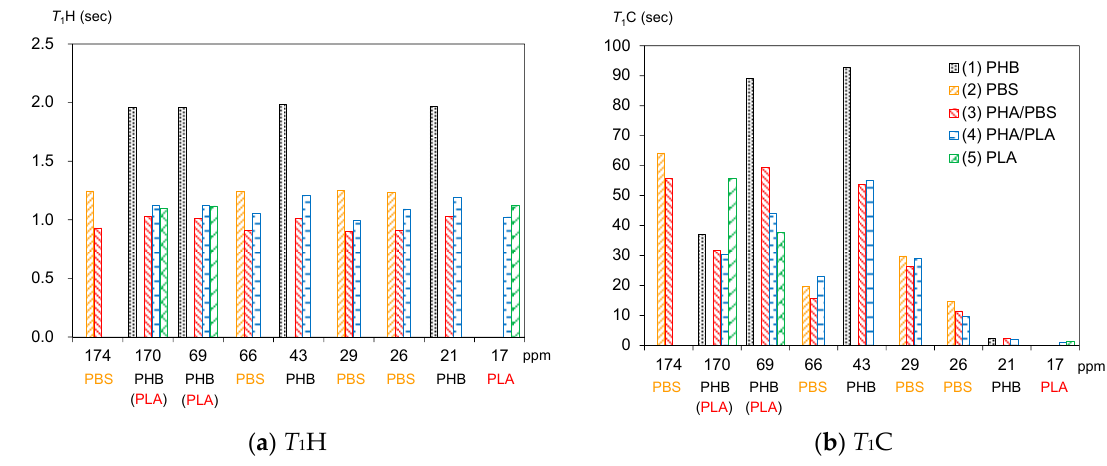
Figure 5. Changes of T 1 H and T 1 C values with copolymerization. The horizontal axis shows the chemical shift of each signal appearing in the 13 C cross-polarization (CP) MAS NMR spectra while the vertical axis shows the corresponding T 1 H ( a ) and T 1 C ( b ) values.